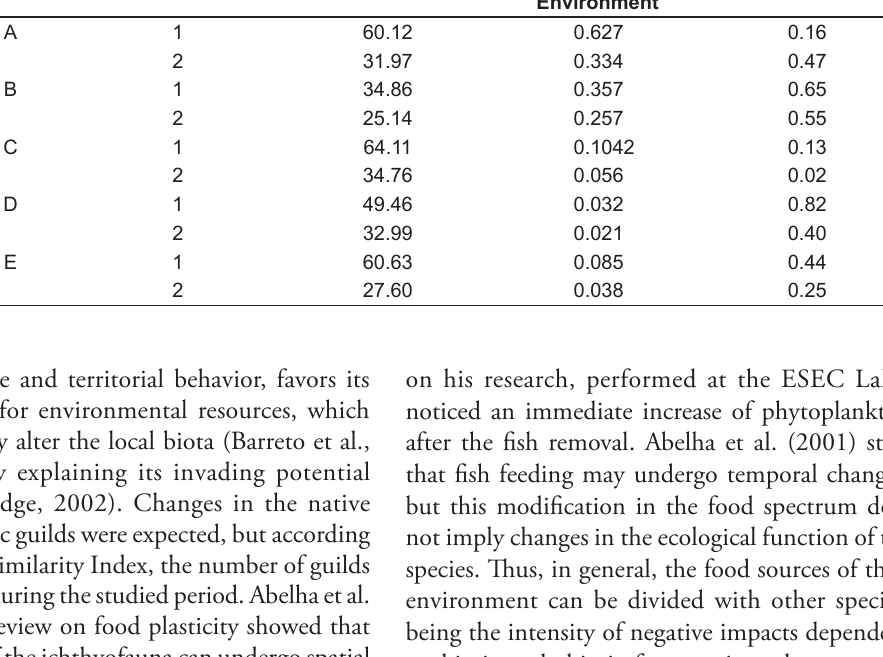
Table 3. Statistical Summary of Canonical Correspondence Analysis of the data from the Alimentary Index of species and environmental variables for months of collection at the Estação Ecológica do Seridó (ESEC-Seridó), Serra Negra, Rio Grande do Norte, Brazil. Statistical